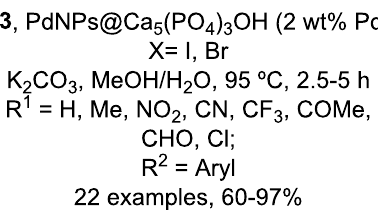
Figure 25. PdNPs supported on metal hydroxides as catalysts for Sonogashira couplings. Conditions, substrate scope and yield range (Scheme 2).